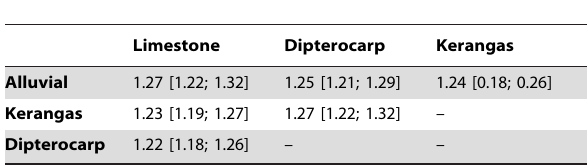
Table 5. Unbiased estimated Shannon beta-diversity * D b between the four forest types as calculated after the framework of Marcon et al.